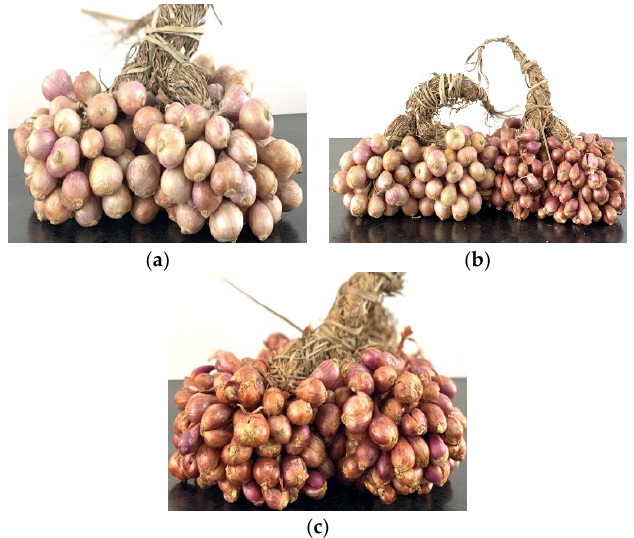
Figure 1. Photos of Allium cepa var aggregatum (White) ( a ); Allium cepa var aggregatum (White and Pink varieties together) ( b ) and Allium cepa var aggregatum (Pink) ( c ).